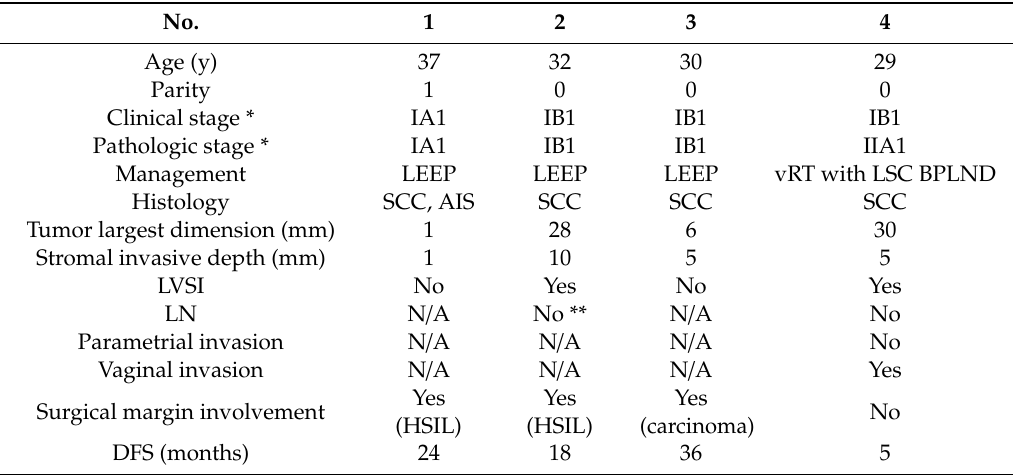
Table 3. Characteristics of four early-stage invasive cervical cancer women with recurrent CIN or ICC without definitive treatment after fertility-sparing